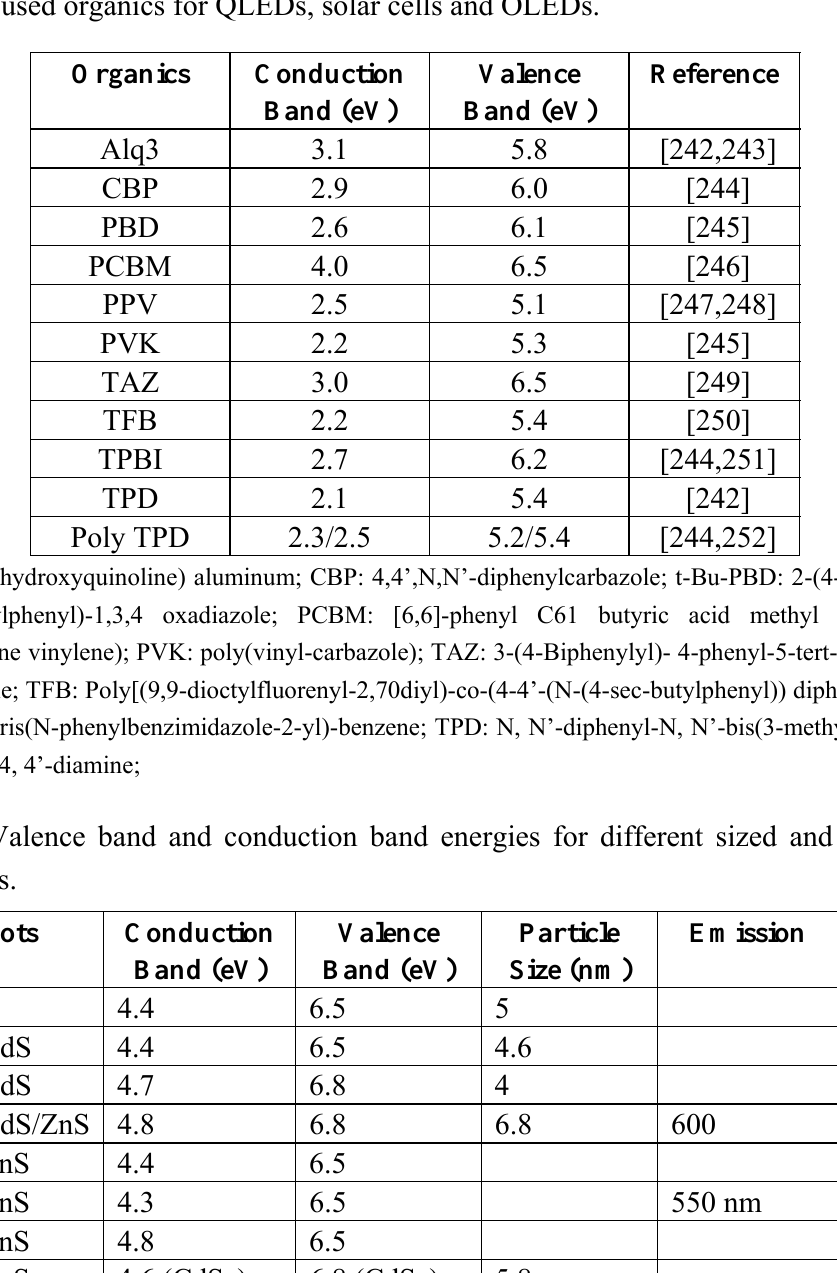
Table 4. Valence band (HOMO) and conduction band (LUMO) energies for some of the commonly used organics for QLEDs, solar cells and OLEDs.